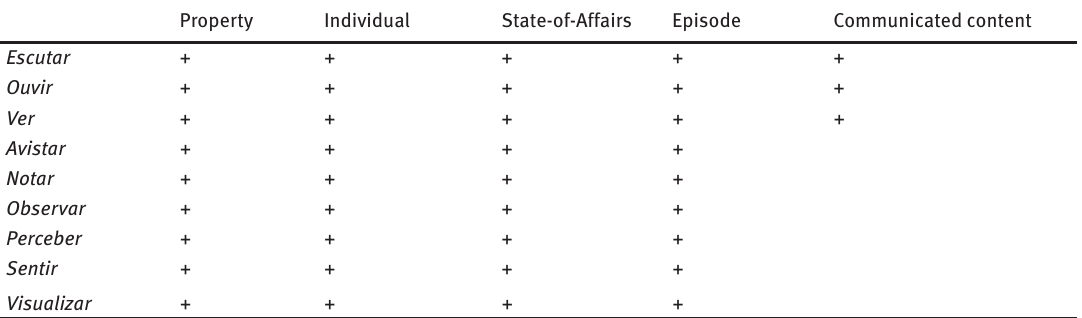
Table 4. Perception verbs exhibiting a wide range of semantic complement